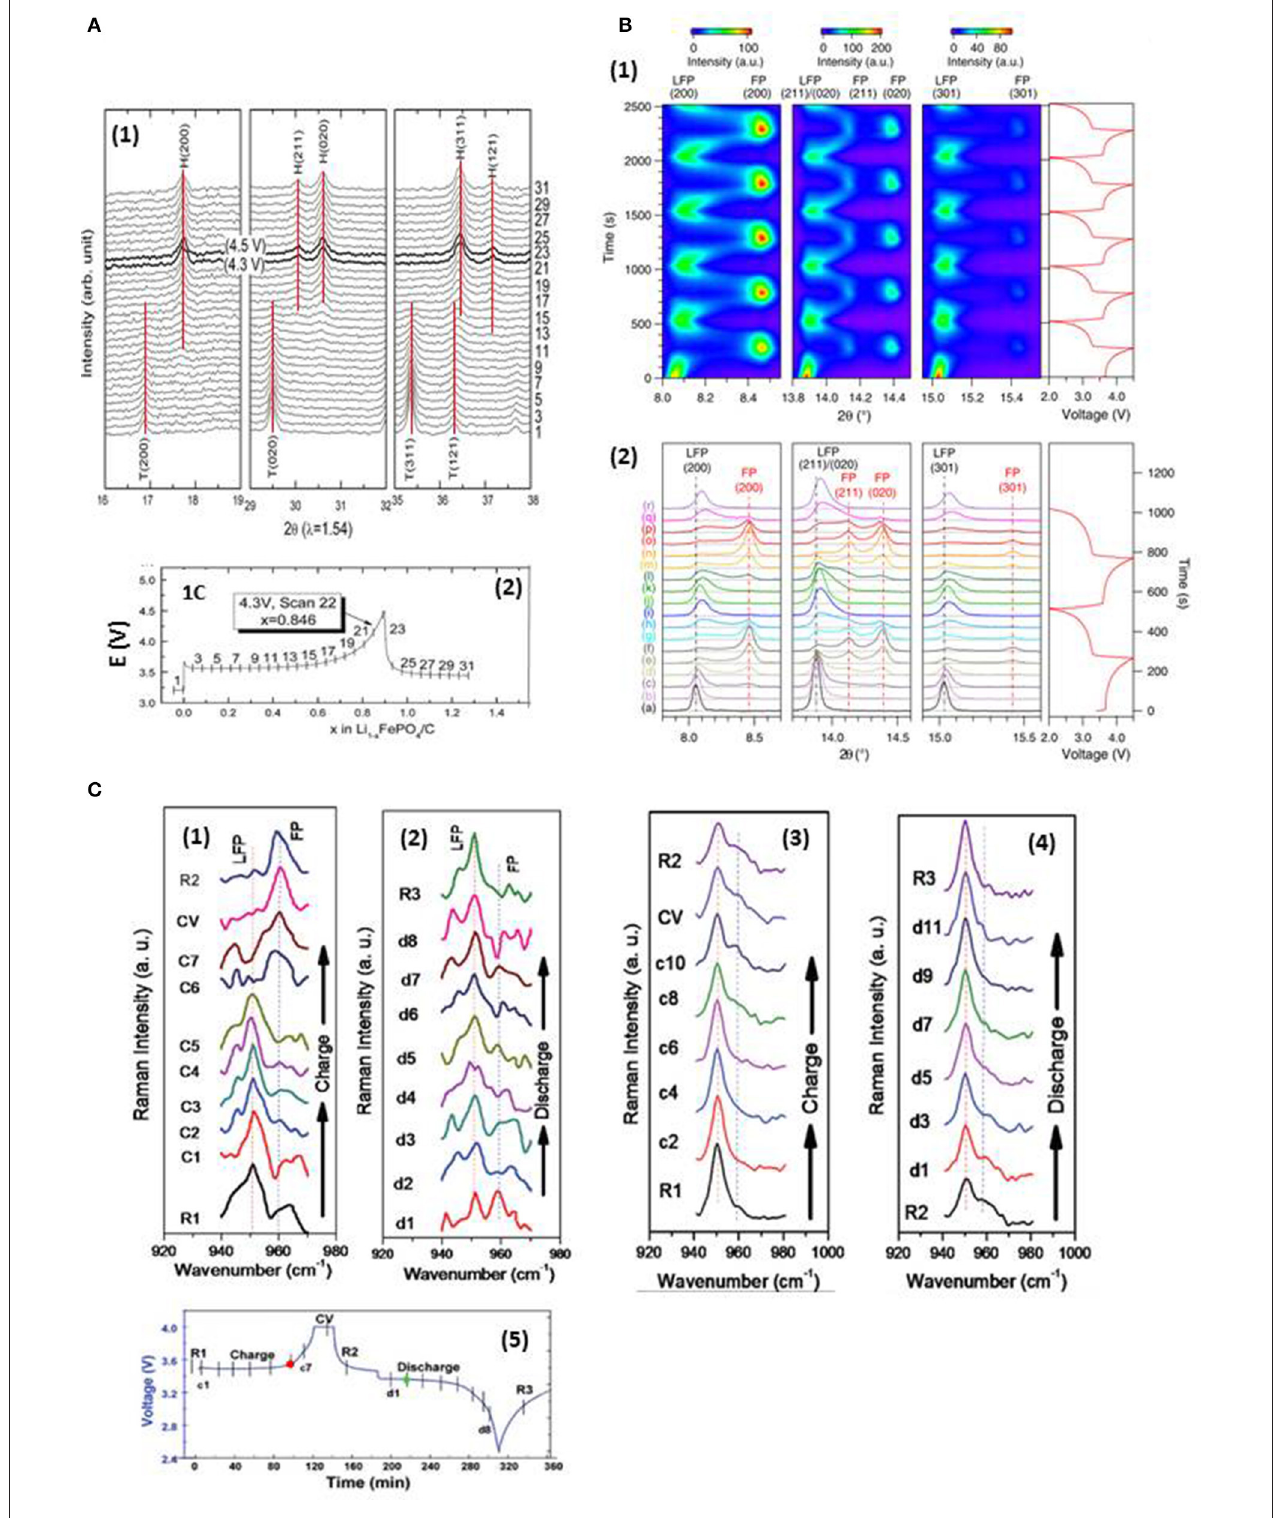
FIGURE 4 | (A) C-coated LiFePO 4 charged at 1C rate (A1) Evolution of XRD spectra shows that the FP is first detected at Li = 0.62, and the LFP disappears completely at 4.3V; ( A2) corresponding charge-discharge curve (Shin et al., 2011 with permission from Elsevier); (B) LFP cycled at a rate of 10C (Liu, H. et al., 2014); (B1) image plot of diffraction patterns for (200), (211), (020), and (301) reflections during first five cycles; the scale bars of diffraction intensity are shown on top.